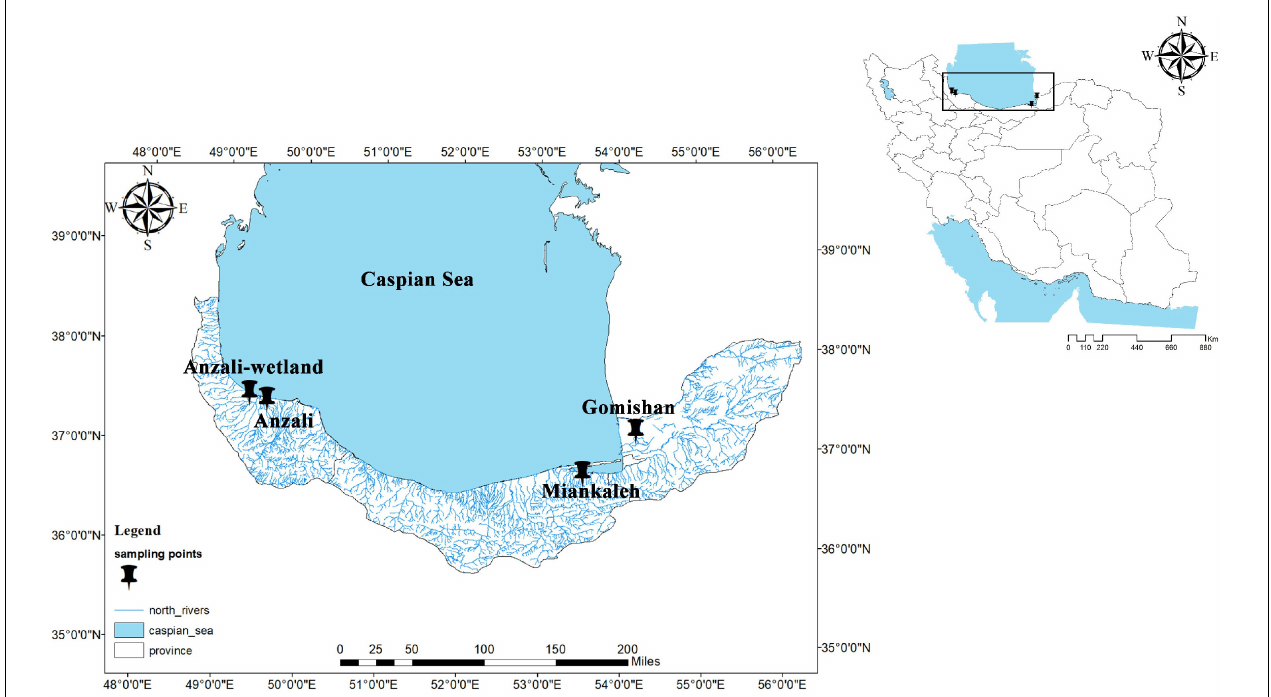
FIGURE 1 | Sampling locations of wild C. carpio specimens across the southern Caspian